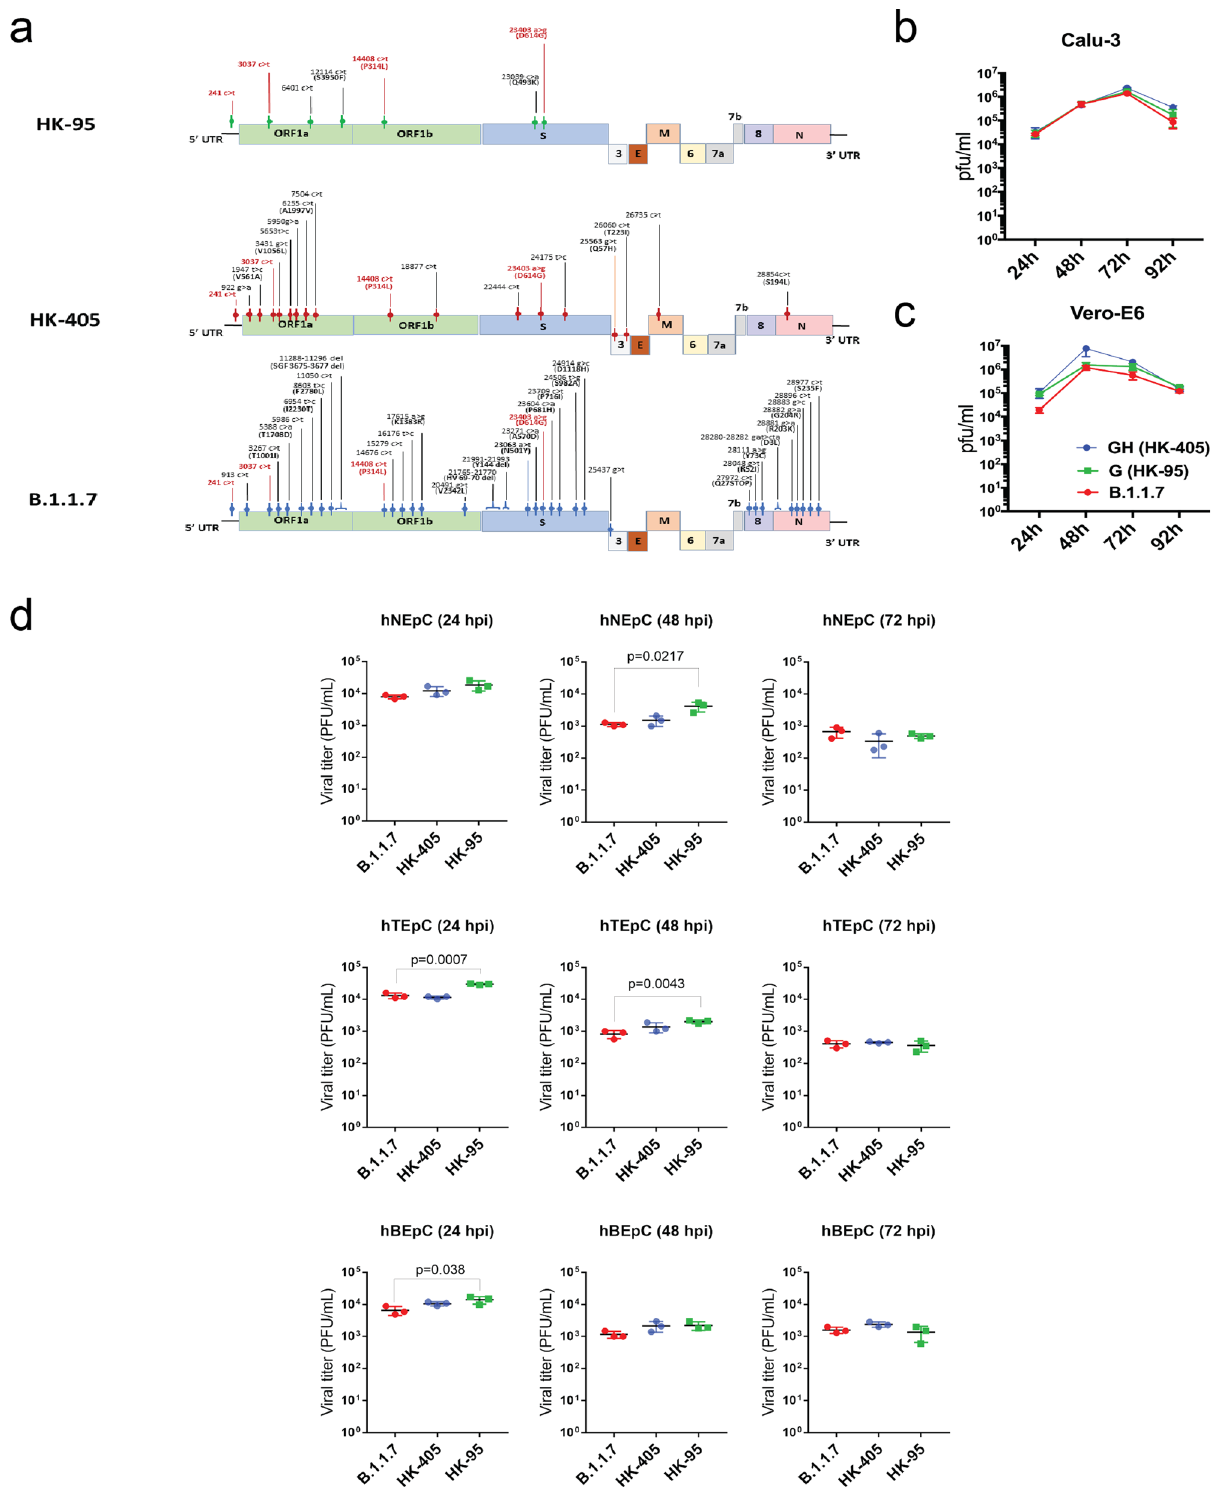
Fig. 1 Viral growth kinetics of Sars-CoV-2 D614G variants. a Genomic sequence comparison of the D614G variants used in this study to the reference genome (accession number: NC_0.45512.2). Common SNPs in all thee strains are shown in red. b and c Growth curves of B.1.1.7, HK-405 and HK-95 in Calu-3 cells and Vero-E6 at a MOI = 0.01 and MOI = 0.001, respectively. Virus-infected cells were cultured at 37 °C and supernatants then harvested at the indicated time points and subjected to plaque assay in Vero E6 cells to determine the virus titre. Error bars represent mean ± SD ( n = 3 per group for each timepoint). d Comparison of 24, 48 and 72 h titres between B.1.1.7, HK-405 and HK-95 infected primary nasal (hNEpC), trachel (hTEpC) and bronchial (hBEpC) epithelial cells (PromoCell) at MOI = 0.1. Triplicated titres of the viruses in the cultures from the cell lines were analysed by Student ’ s t-test. Horizontal lines indicate the mean ± SD of viral titre per